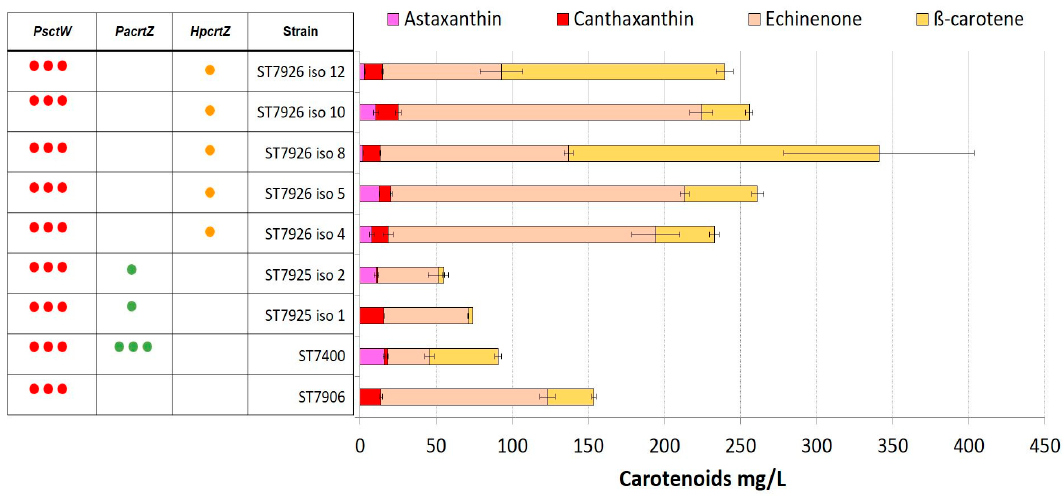
Figure 3. Carotenoid production by strains ST7925 and ST7926. Set of yeast transformants expressing PscrtW in combination with either PacrtZ or HpcrtZ . Positive control: ST7400; Parent strain: ST7906. All strains were cultivated in YP + 8% glucose in 24-deep-well plates for 72 h. Three dots represent multiple integrations of genes and one dot represents single integration. The error bars represent standard deviations calculated from triplicate experiments (“iso” after each strain indicates the isolate number).